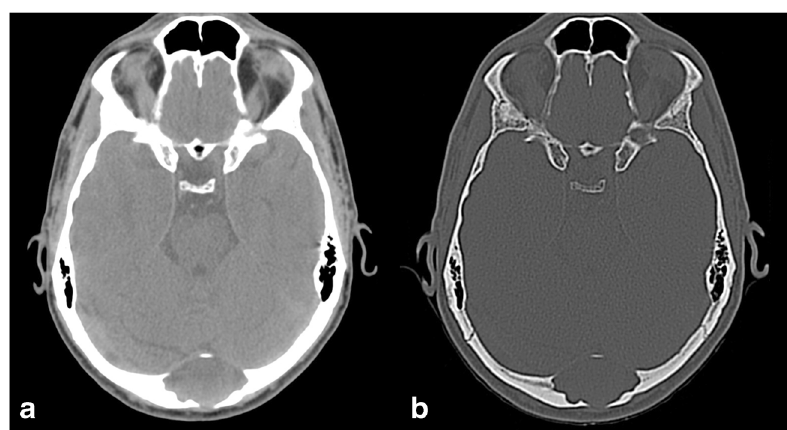
Fig. 3 Intradiploic epidermoid cyst (IEC). Axial CT images with soft tissues ( a ) and bone ( b ) windows show an occipital hypodense osteolytic lesion with smooth margins and greater involvement of the inner table, extensively